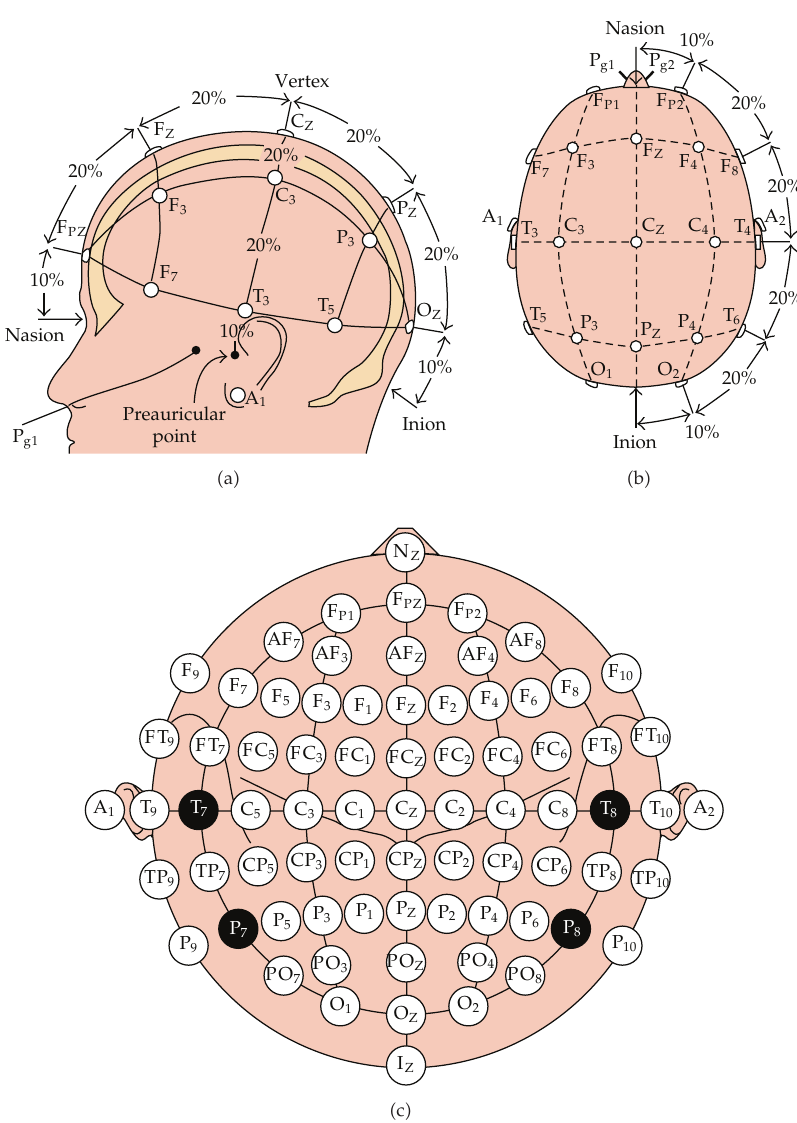
Figure 1: Standard electrode positioning as per the International 10–20 system (cid:3) 49 (cid:4)